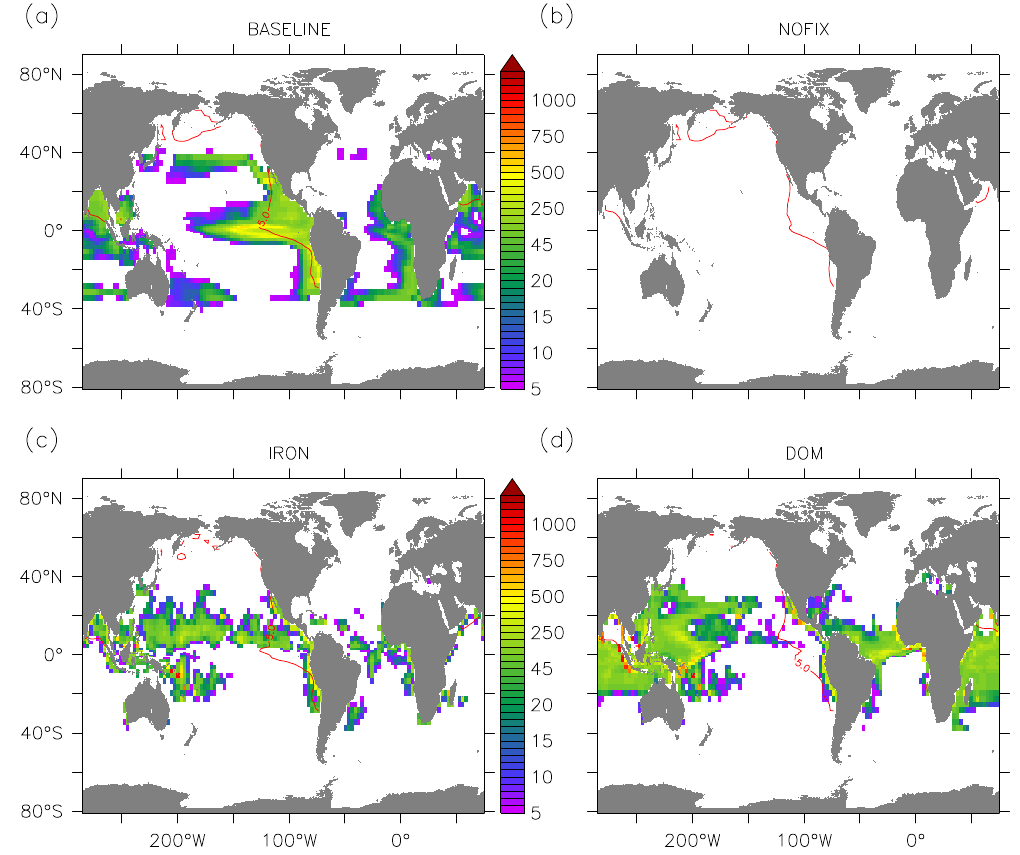
Fig. 2. N 2 fixation rates (mmolNm − 2 yr − 1 ) calculated for the (a) BASELINE, (b) NOFIX, (c) IRON and (d) DOM simulation. Red contour denotes the average position of the 5mmolm − 3 O 2 isoline at the local vertical minimum of dissolved oxygen. Figure shows averages over 150 model